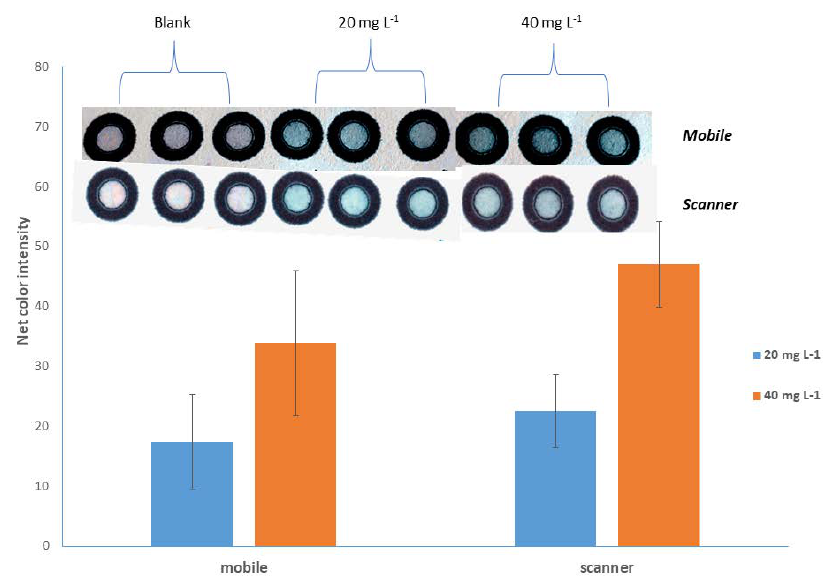
Figure 2. Effect of the photograph-receiving device. Error bars indicate the standard deviation for n =